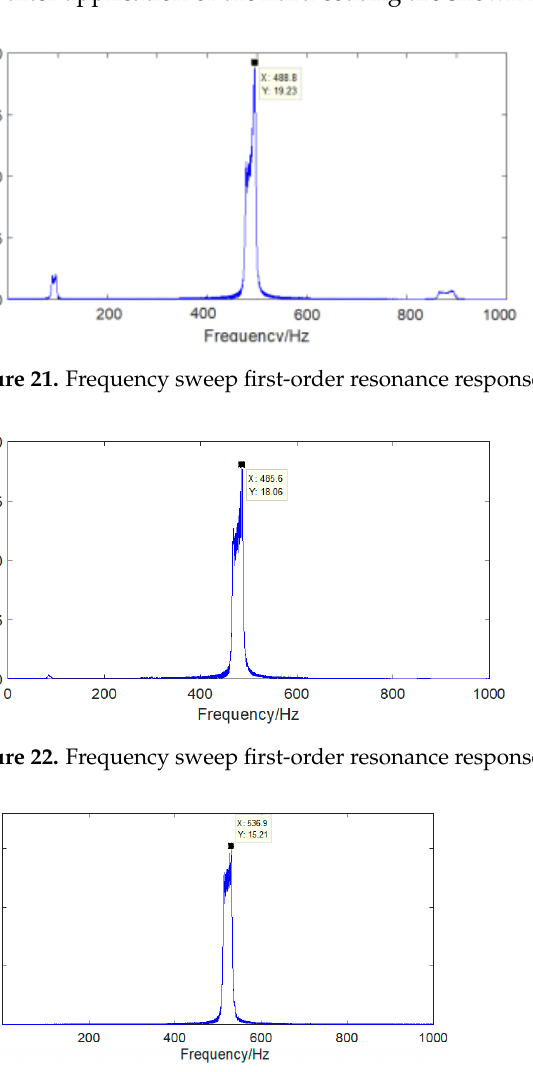
Figure 24. Frequency sweep vibration response of galvanized iron clamp with a 200 ‐μ m ‐ thick hard coating of Al ‐ Cu ‐ Fe ‐ Cr.